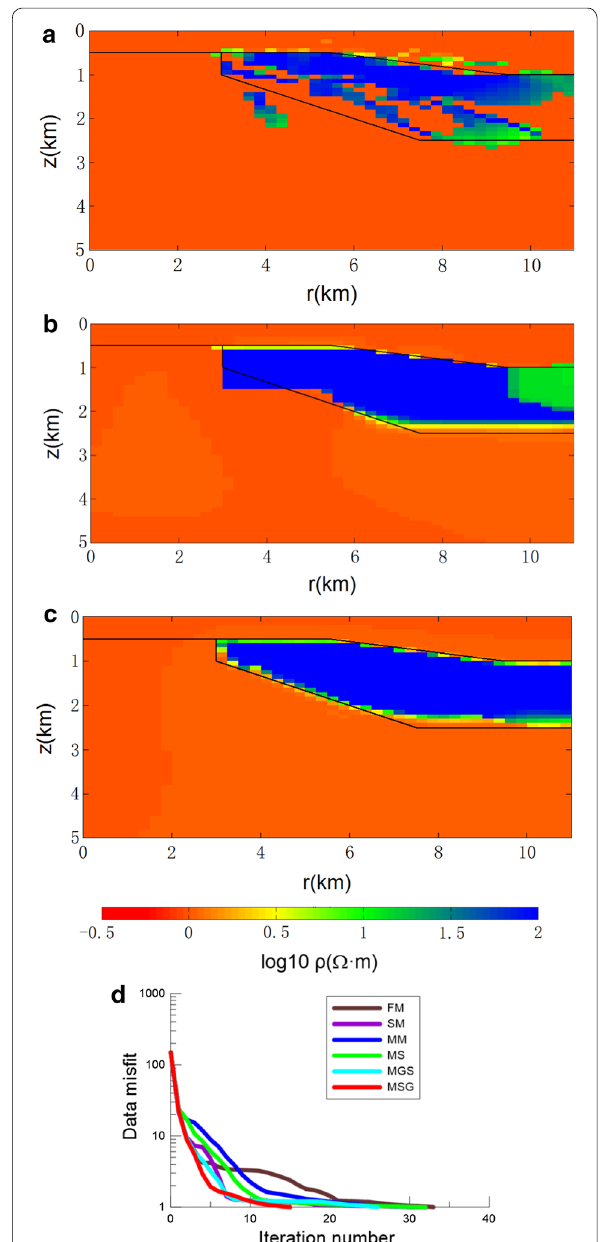
Fig. 10 Synthetic inversion results for the 2D resistive model (Fig. 6a) using different stabilizing functionals with β 2 c MSG results, and d convergence of RMS data misfit. Color scale is the same as Fig.